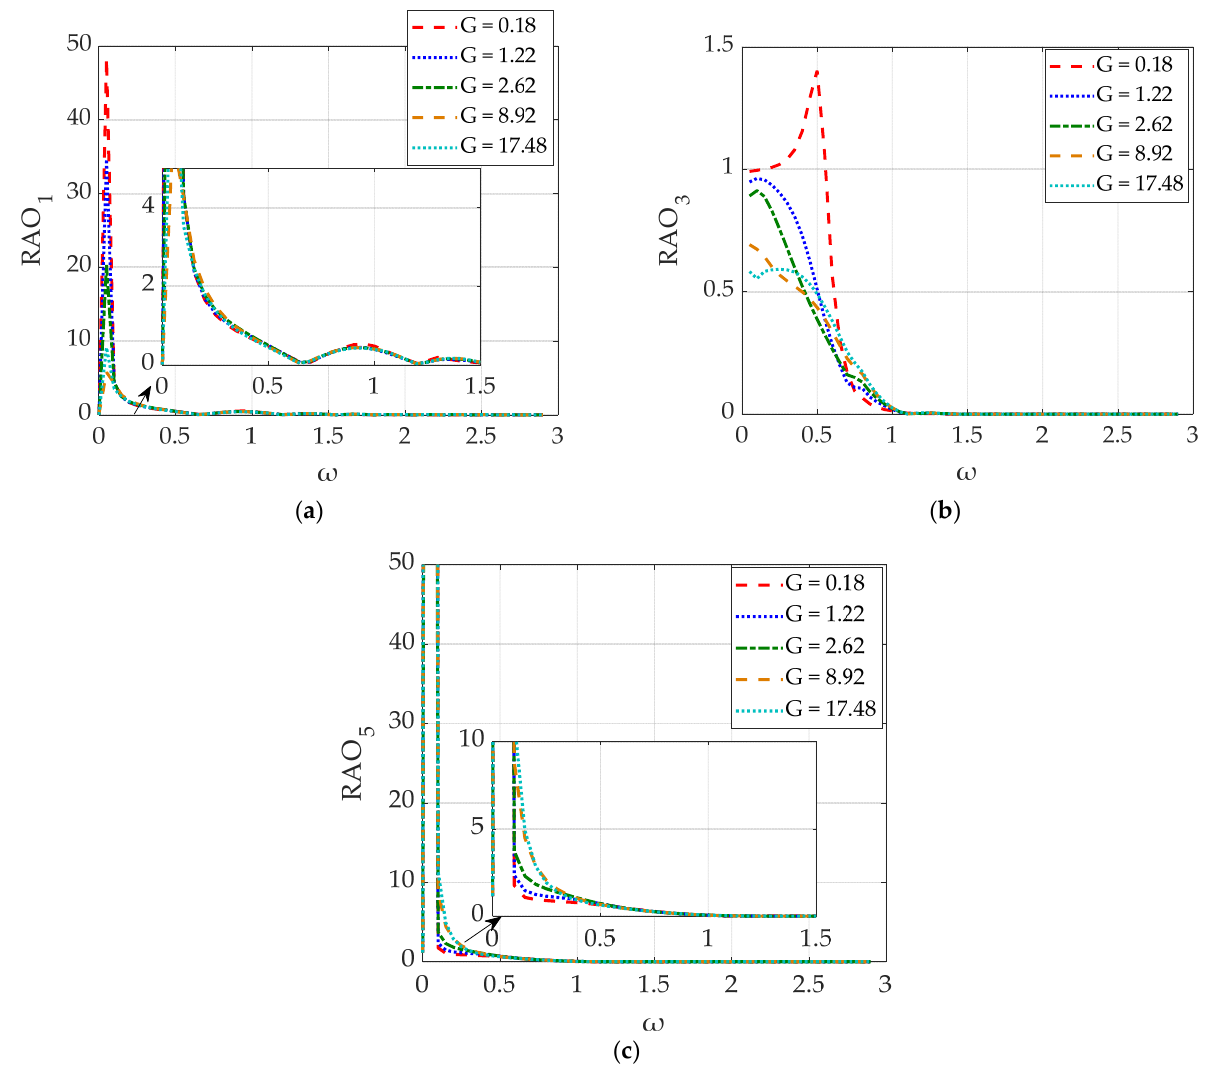
Figure 8. Dimensionless motions RAO 1 ,RAO 3 , RAO 5 of the permeable cylindrical body against wave frequency ω for various values of porous effect parameter G = 0.18, 1.22, 2.62, 8.92, and 17.48: ( a ) RAO 1 ; ( b ) RAO 3 ; ( c ) RAO 5